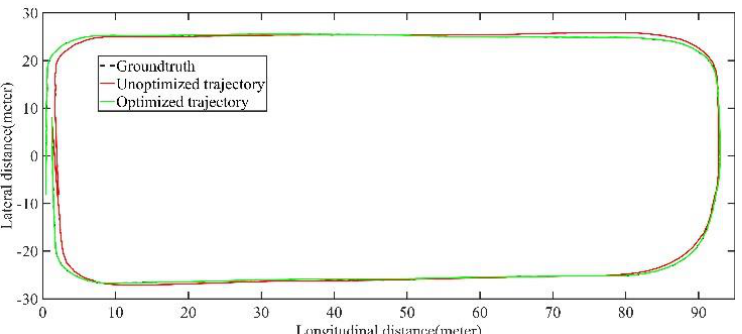
Figure 14. The comparison of trajectory before and after optimization with groundtruth of small scale scenario.